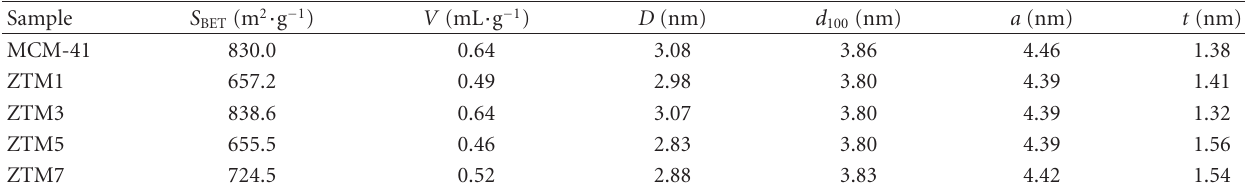
Table 1: Textural characteristics of MCM-41 and ZTM series samples.